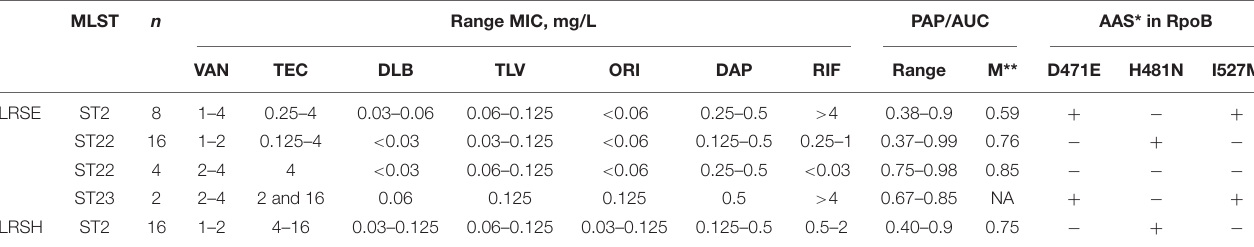
TABLE 2 | Glycopeptide and lipoglycopeptides susceptibility and PAP analysis in linezolid-resistant coagulase-negative